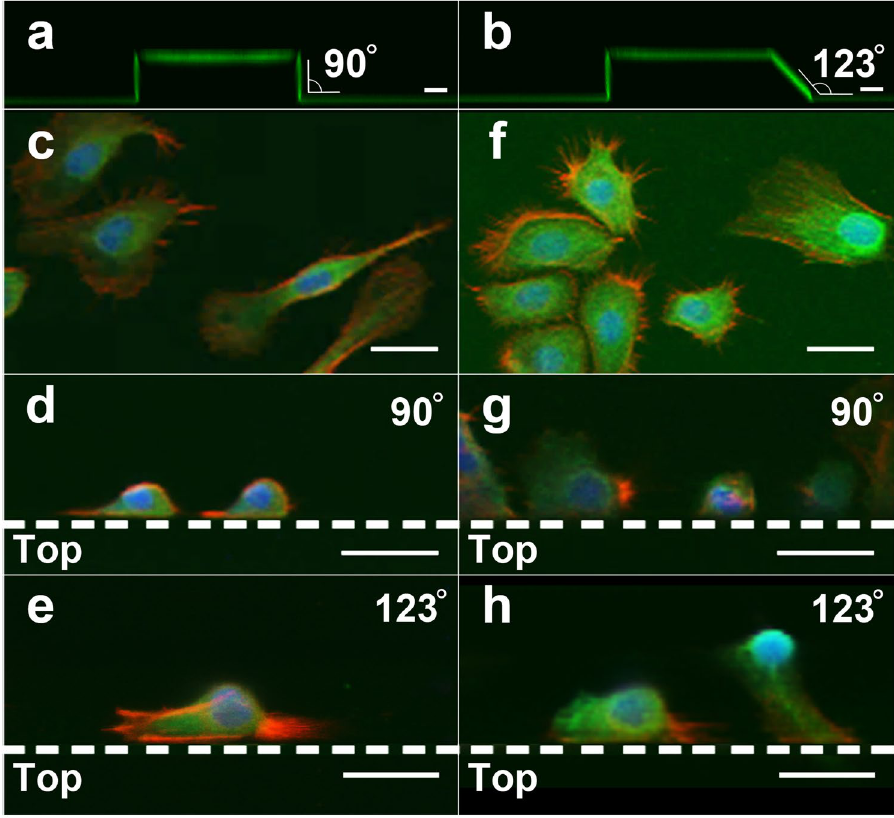
Figure 2. Confocal image of the microgroove-based structures with ( a ) 90° wall and ( b ) 123° wall visualized by the adsorbed FITC-BSA. Immunostaining (20x) of actin (red), vinculin (green) and nucleus (blue) of ( c–e ) RWPE1 (non-cancerous; polarized) and ( f–h ) RWPE2 (cancerous; non-polarized) cells on ( c,f ) flat surfaces, ( d,g ) upright microgroove structures and ( e,h ) slanted microgroove structures. Dotted lines represent the microgroove wall boundaries, and the ‘Top’ area below the lines represent the top plateau of the microgroove structures. (Scale bar, 20 μ